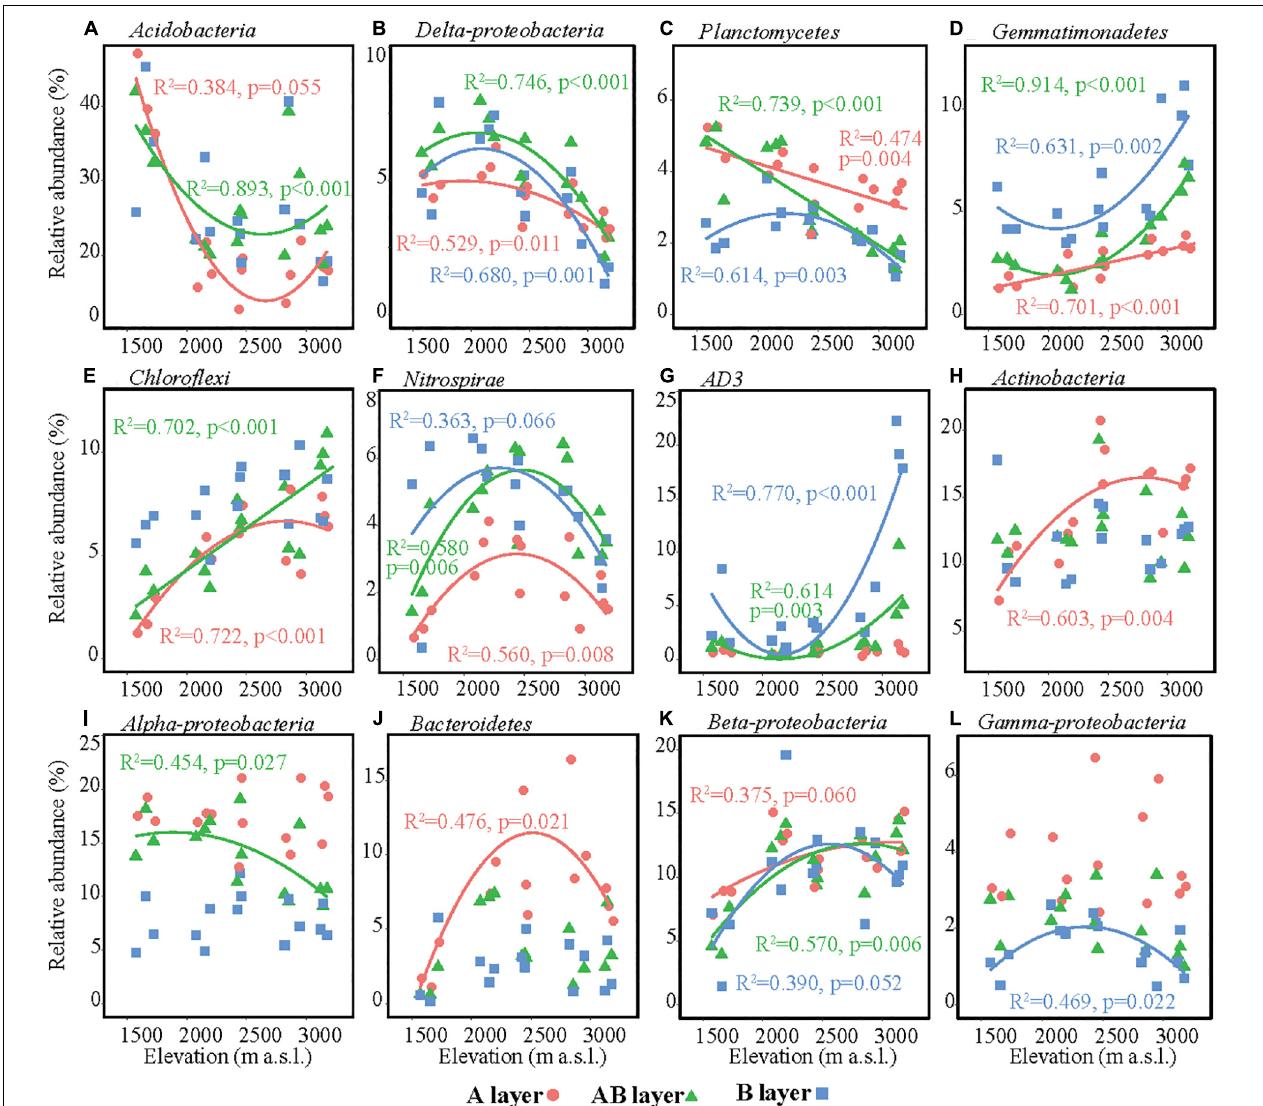
FIGURE 3 | Relative abundances of the dominant bacterial taxa along the elevational gradient. (A) Acidobacteria, (B) Delta-proteobacteria, (C) Planctomycetes, (D) Gemmatimonadetes, (E) Chloroflexi, (F) Nitrospirae, (G) AD3, (H) Actinobacteria, (I) Alpha-proteobacteria, (J) Bacteroidetes, (K) Beta-proteobacteria, (L) Gamma-proteobacteria. Lines in each plot represent the least squares regression